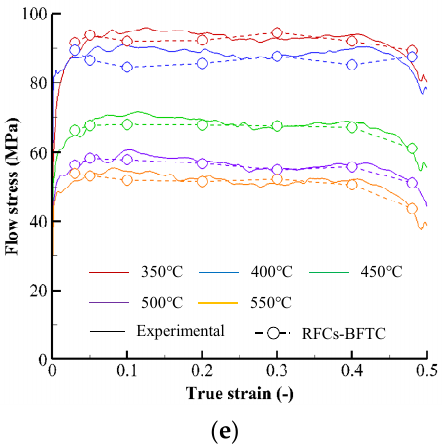
Figure 3. Primitive flow curves, i.e., FRCs–BFTCs: ( a ) 0.1 s − 1 , ( b ) 1 s − 1 , ( c ) 5 s − 1 , ( d ) 10 s − 1 , and ( e ) 20 s − 1 .